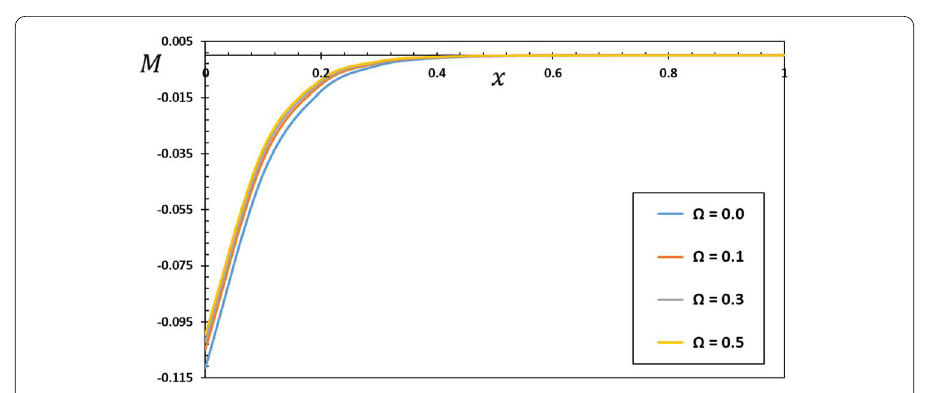
Figure 5 The effect of rotation ( (cid:5) ) on the variation of bending moment M